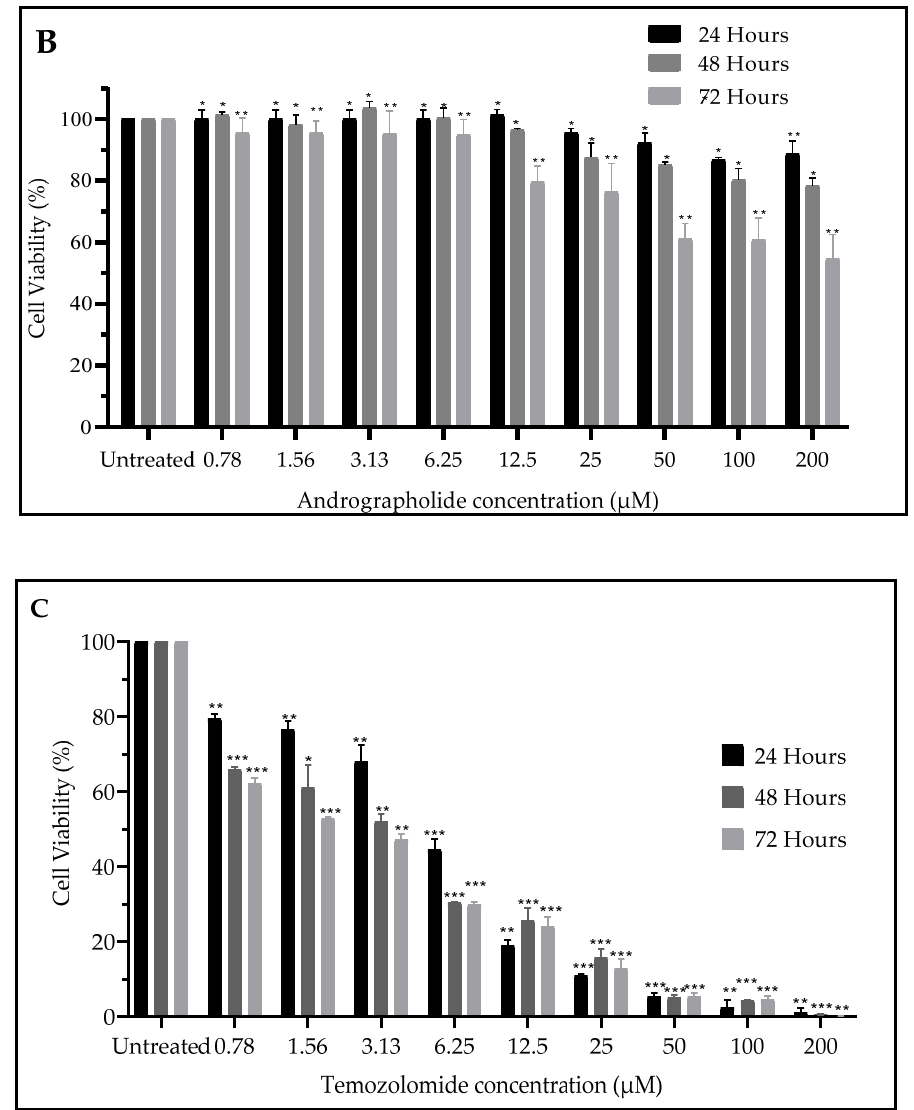
Figure 1. The percentage of cell viability of ( A ) DBTRG-05MG, ( B ) SVGp12 treated with andro- grapholide, ( C ) DBTRG-05MG treated with temozolomide in a time frame of 24, 48, and 72 h. The results were analyzed in GraphPad Prism 8.0.1 (Graphpad software, Inc., San Diego, CA, USA). Data expressed as mean ± SEM and statistical analysis between three independent groups was performed by t-test compared with the untreated group: * p < 0.05, ** p < 0.005, *** p < 0.0005. Table 1. The half-maximal lethal concentration (LC 50 ) values for ( A ) DBTRG-05MG and SVGp12 cells after being treated with andrographolide (0.781–200 µM) and ( B ) DBTRG-05MG cells after be- ing treated with temozolomide (0.781–200 µM) were estimated using nonlinear regression approx- imations in GraphPad Prism 8.0.1 (Graphpad software, Inc., San Diego, CA, USA).